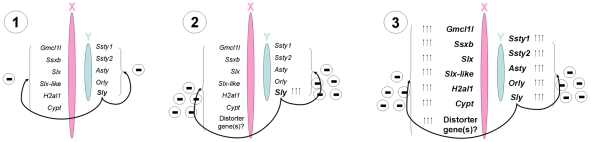
Model of the involvement of Sly in the amplification of postmeiotically expressed genes on the mouse X and Y chromosomes.(1) Sly functions in PSCR, having a repressive effect on sex chromosome-linked spermatid genes such as Gmcl1l, Ssxb, Slx, Slx-like, H2al1, and Cypt on the X and Ssty1, Ssty2, Asty, Orly, and Sly itself, on the Y. (2) Sly becomes amplified in copy number, possibly in response to the presence of a sex ratio distorter on the X. Increasing expression of Sly leads to stronger repression of other sex chromosome-linked spermatid genes via PSCR. (3) Copy number amplification of multiple sex-linked spermatid genes to maintain their expression in the presence of increasing PSCR.